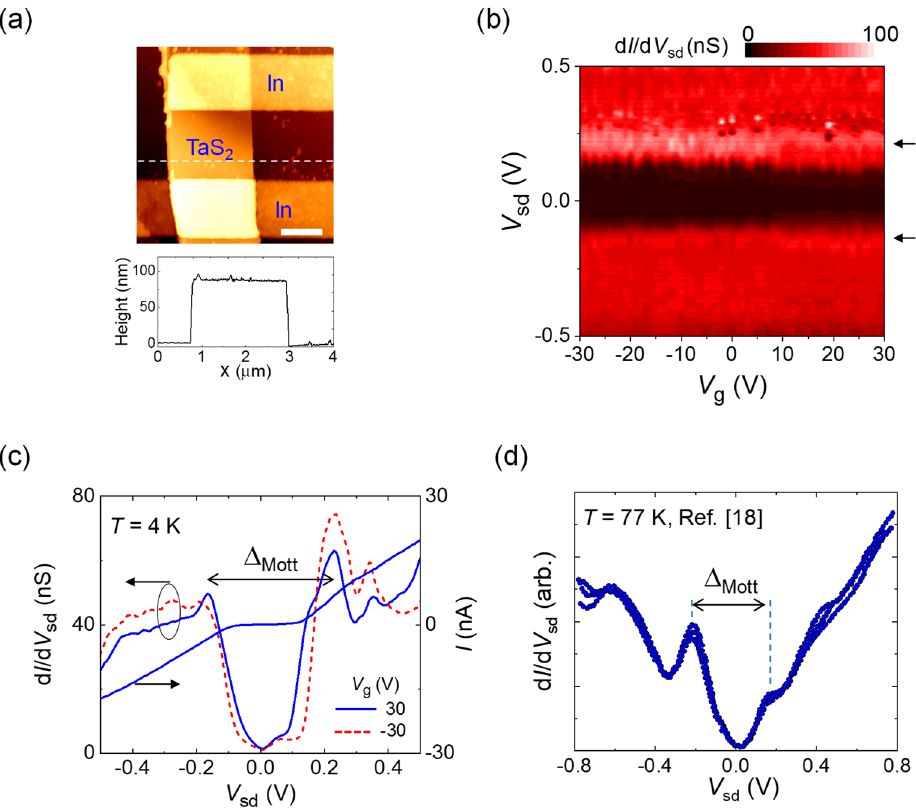
Figure 2. vdW gap tunneling spectroscopy for 1 T -TaS 2 . ( a ) Upper panel: AFM image of a 1 T -TaS 2 FET. Scale bar: 1 µm. Lower panel: height profile along the dashed white line in the upper panel. ( b ) d I /d V sd as a function of V sd and V g at T = 4 K. The two arrows indicate the conductance shoulders corresponding to a gap feature. ( c ) d I /d V sd – V sd curves at V g = ± 30 V and I – V sd curve at V g = 30 V. These curves clearly show an energy-gap feature, indicated by the Mott gap ( Δ Mott ) with a magnitude of ~ 0.4 eV. ( d ) Conventional scanning tunneling spectra obtained from the same 1 T -TaS 2 single crystal at T = 77 K, which shows a similar Δ Mott size with that in ( c ). ( d ) is reproduced with permission from 18 , 1994 AMERICAN PHYSICAL